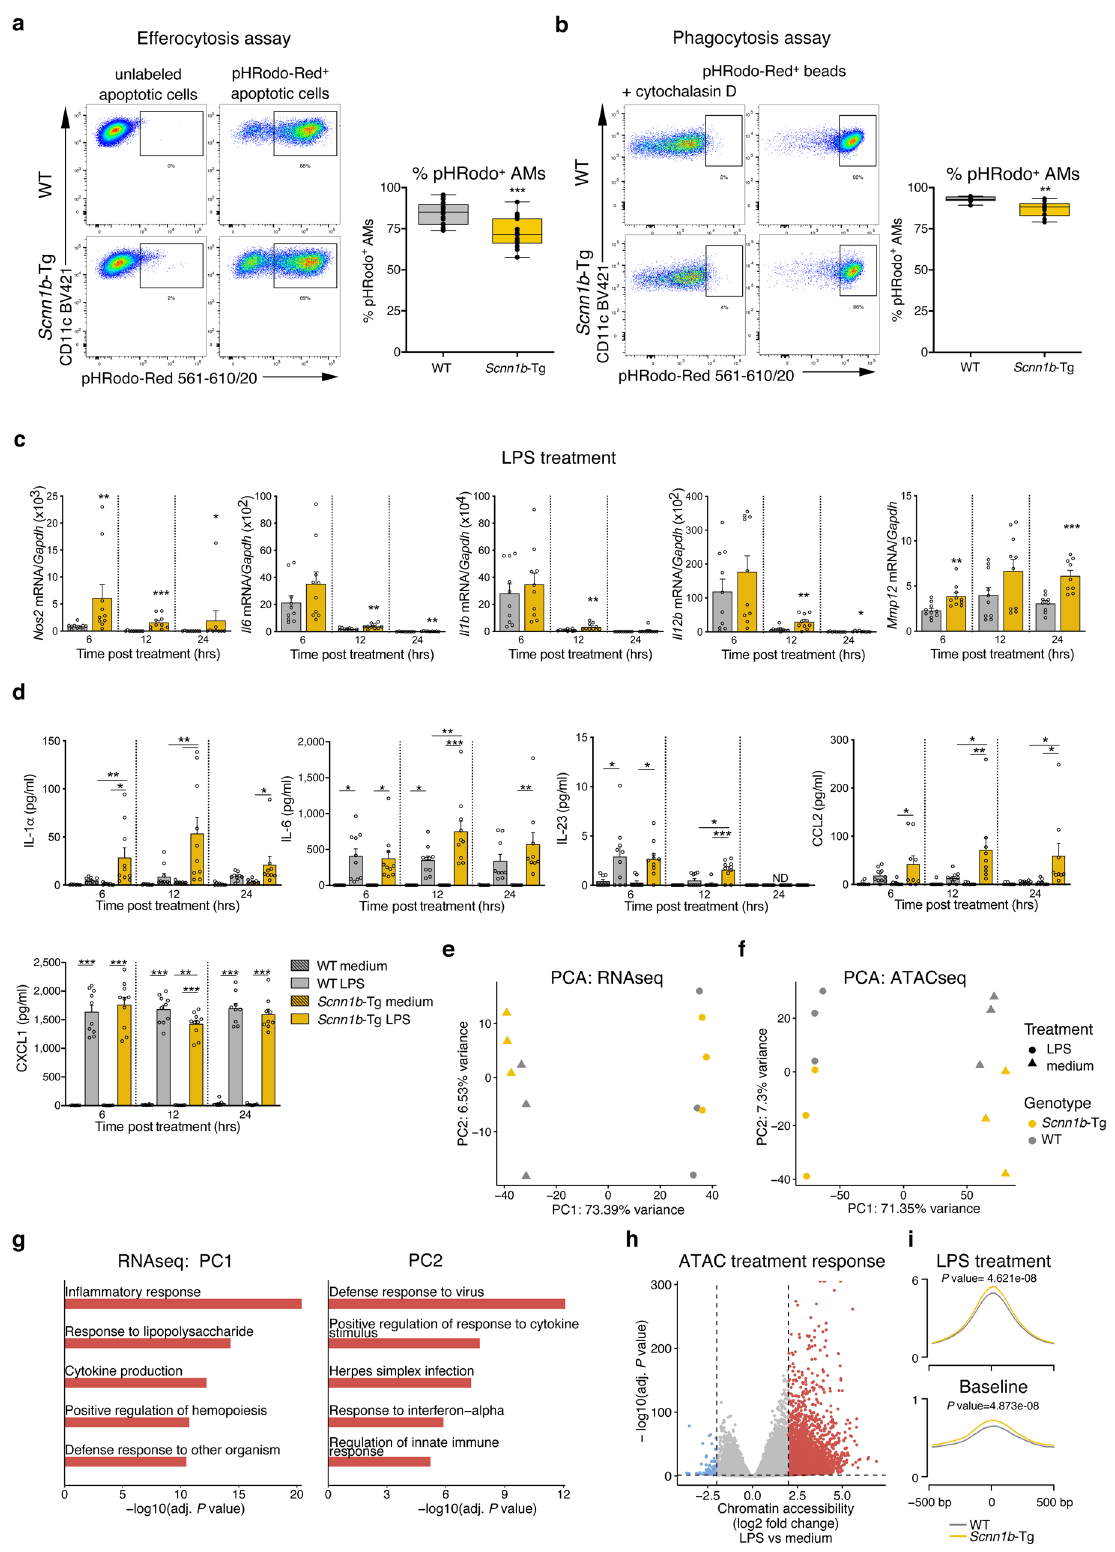
Another major problem in muco-obstructive lung diseases is bacterial airway infections, triggering acute exacerbations and disease progression 52 . We evaluated the phagocytic capacities of AMs, using pHRodo labeled E. coli particles and identi fi ed a signi fi cant reduction of phagocytosis in Scnn1b -Tg AMs com- pared to WT AMs (Fig. 4b and Supplementary Fig. 7c). To